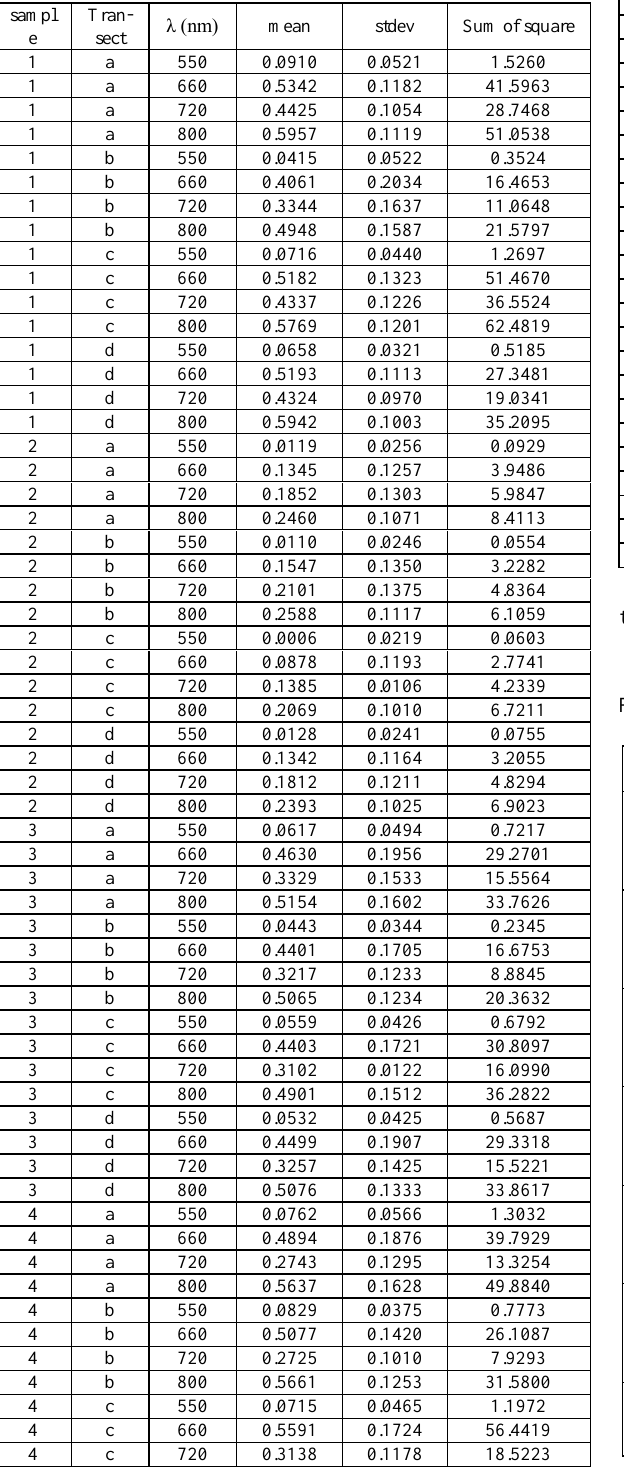
Figure 5. Transects where pixel values were extracted. Figure 5 shows four transects along each of the 6 crowns sampled. The average was calculated for the pixels of each one with the values of spectral reflectance factor in each of the four wavelengths analysed and the residuals as well. A linear and a quadratic polynomial equation were adjusted based on minimum of the square error. The parameters: mean, standard deviation and sum of square are presented in the table 2.